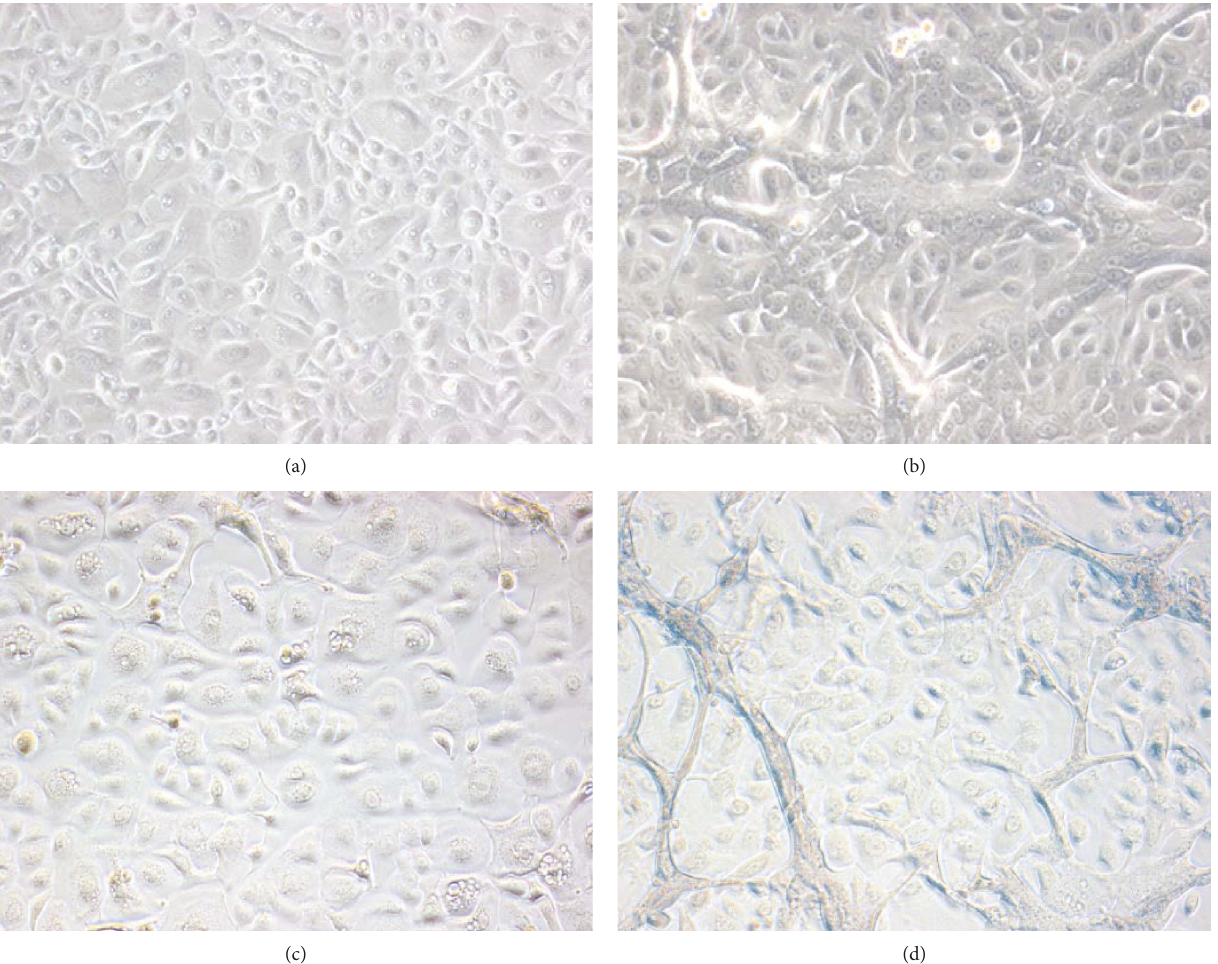
Figure 6: PRGF-treated primary human keratinocytes display morphologic features typical for keratinocytes in their late terminal di ff erentiation phase. During all in vitro experiments, PRGF-treated primary human keratinocytes revealed a morphology that is a characteristic for keratinocytes undergoing terminal di ff erentiation such as growth in several layers and loss of distinct cell borders. Shown are untreated primary human keratinocytes cultured for 24 hours (a) and 48 hours (c) compared to primary human keratinocytes treated with PRGF (1 :10) for 24 hours (b) and 48 hours